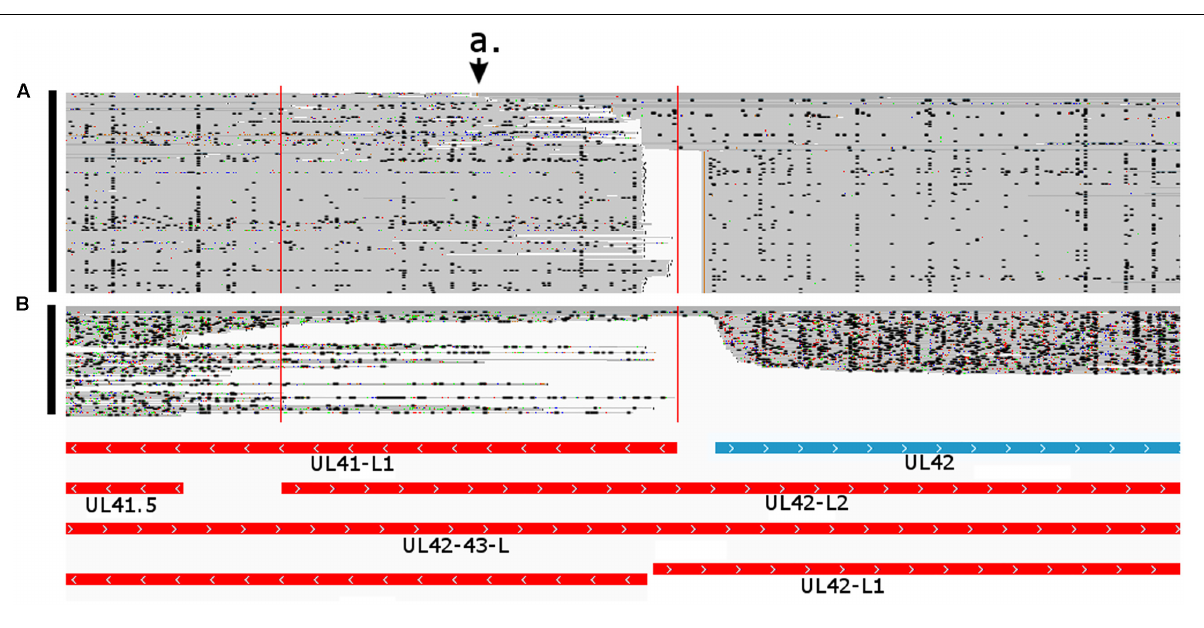
FIGURE 7 | Divergent transcriptional overlap of multiple transcripts in the ul41-ul43 gene cluster. The arrow a. points to the overlapping region delimited by the vertical red lines. The blue box represent already known UL42 transcript, while the red boxes represent novel transcripts. Reads of the PacBio IsoSeq (A) and MinION cDNA (B) sequencing were visualized in compact mode using